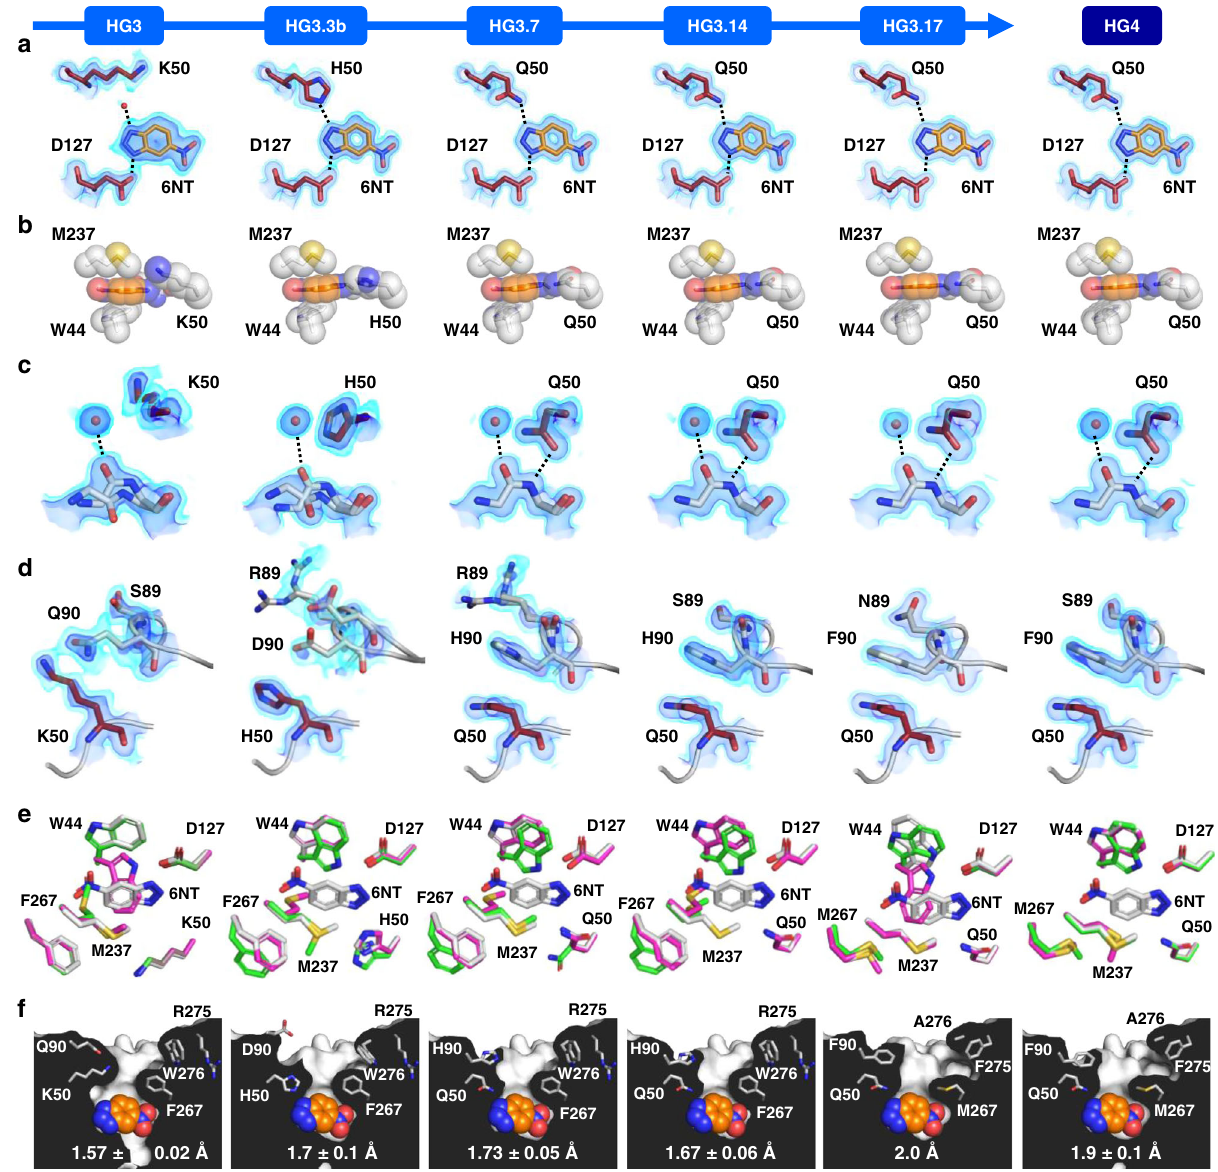
Fig. 2 Crystal structures of HG-series Kemp eliminases. In all cases, only atoms from chain A are shown. a Binding pose of the 6-nitrobenzotriazole (6NT) transition-state analogue (orange). Hydrogen bonds are shown as dashed lines. The red sphere represents a water molecule. The 2Fo-Fc map is shown in volume representation at two contour levels: 0.5 and 1.5 eÅ − 3 in light and dark blue, respectively. b 6NT (orange) is sandwiched between the hydrophobic side chains of Trp44 and Met237. c The peptide bond between residues 83 and 84 can adopt cis or trans conformations. Hydrogen bonds are shown as dashed lines. The 2Fo-Fc map is shown in volume representation at two contour levels: 0.5 and 1.5 eÅ − 3 in light and dark blue, respectively. d Conformational changes to the loop formed by residues 87 – 90 over the course of the evolutionary trajectory. The 2Fo-Fc map is shown in volume representation at two contour levels: 0.5 and 1.5 eÅ − 3 in light and dark blue, respectively. e Superposition of the 6NT-bound structure (white) with the highest (magenta) and lowest (green) occupancy conformers of the unbound structure for each Kemp eliminase. From HG3 to HG3.14, the unbound state is never pre-organized for catalysis as both Trp44 and Met237 adopt conformations that would prevent the productive binding of the transition state. In HG3.17 and HG4 however, only Trp44 adopts a non-productive conformation in the unbound state, with an occupancy of 62% or 26%, respectively. f Cut- away view of the active site shows that its entrance (top) becomes widened during evolution, as indicated by an increasing bottleneck radius (reported as the average radius ± s.d. calculated using the highest occupancy conformers from both chain A and B, except for HG3.17, which contains a single chain). 6NT is shown as orange spheres. Bottleneck radii were calculated using the PyMOL plugin Caver 3.0 22